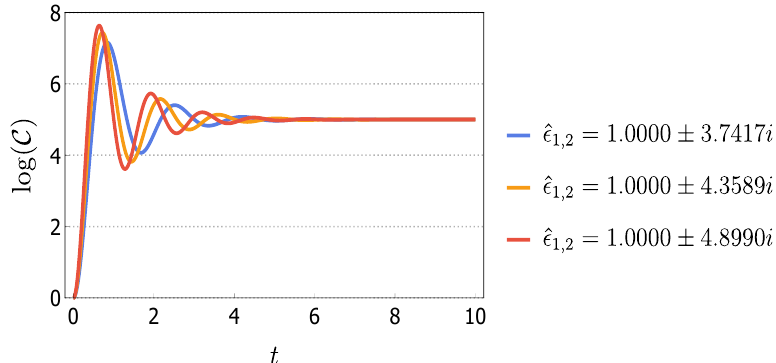
Figure 6 . Evolution of Complexity for a K = 2 parameter system with a variation of eigenvalue of Encoder-Dataset tensor A ∞ in a non-chaotic regime. The non-zero complex part of the eigenvalues of A ∞ gives rise to the oscillatory behavior of the Complexity.